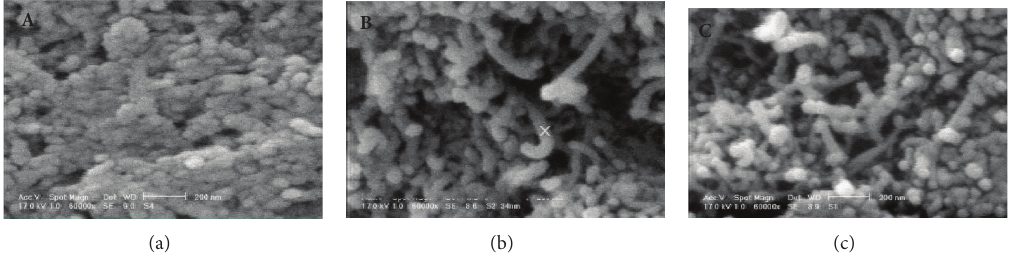
F 6: Scanning electron microscopy images of (a) MWNT-COOH, (b) MWNT- (11H-indeno[1,2-b]quinoxaline-11-ylidene)benzene- 1,4-diamine, and (c) MWNT-